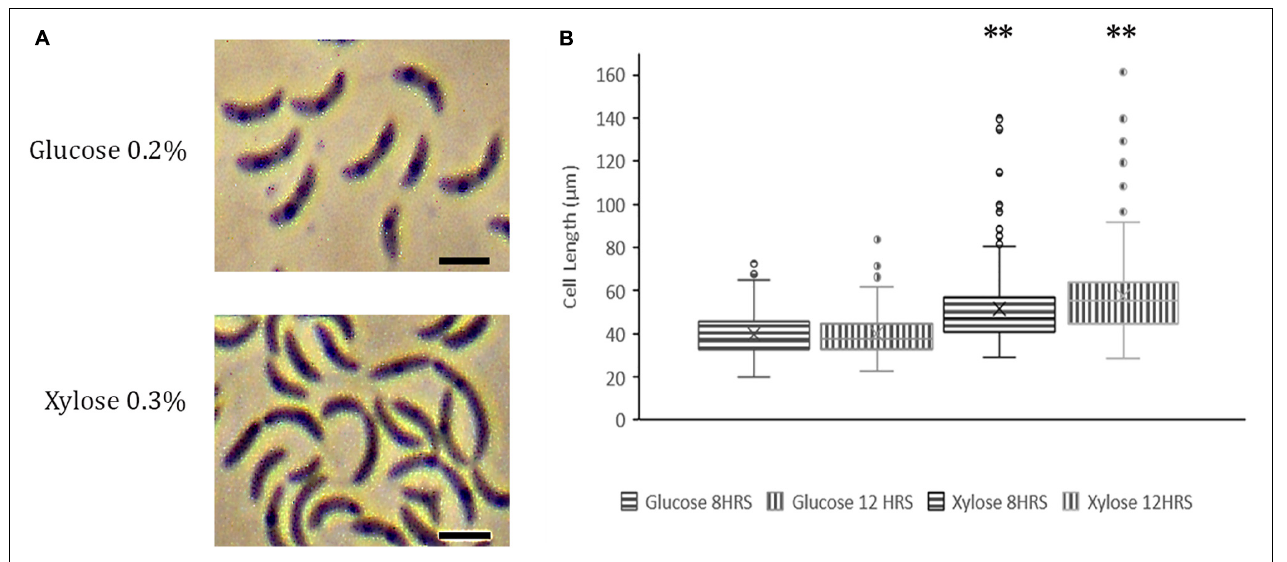
FIGURE 6 | YbaB Cc overexpression in wild-type C. crescentus . (A) Overexpression of YbaB cc leads to morphological defects in C. crescentus . Expression of YbAB Cc from plasmid pJS14 was induced by the addition of 0.3% xylose at an OD of 0.2 and cells were visualized at the indicated time points by Phase Contrast Microscopy (left panel). All images were taken at 100X magnification and optical zoom 1.5X (Scale bar: 2 µ m). (B) Distribution of cell length in populations of YbaB Cc overexpressing cells. Micrographs of the strains described in (A) were subjected to automated image analysis. Cell lengths were determined by Oufti Software. Box and whisker plots ( n = ± 210 per time point and strain) were generated for statistical analysis of imaging data with the whiskers including all data points within 1.5 ∗ IQR. Cross (x) represents mean values. ∗∗ p < 0.0001 by one-way ANOVA compared to the glucose-induced control